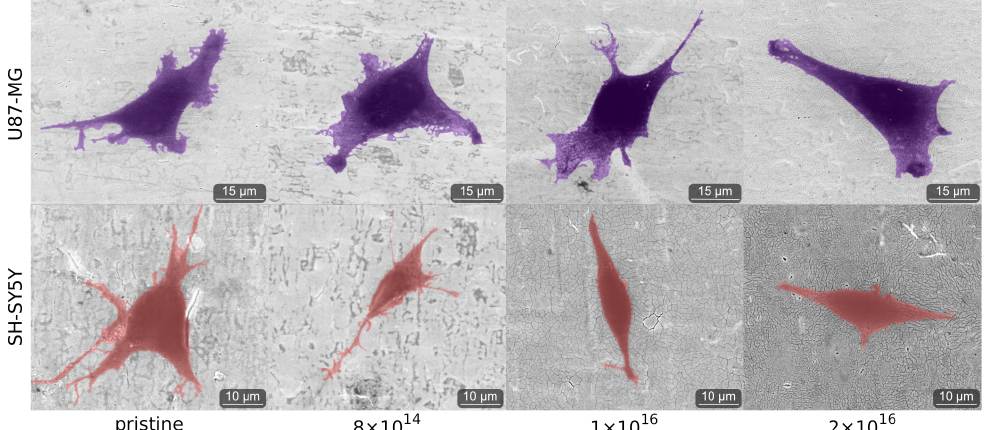
Figure A4. Analyzed extensively expanded U87-MG and SH-SY5Y cells after one day on examined TNSs. U87-MG cells are stained purple and SH-SY5Y cells are labeled pink. Increasing C implantation leads to a decline in cell protrusions of U87-MG cells. SH-SY5Y cells exhibit a decrease in the number and length of cell fibers upon rising implantation of